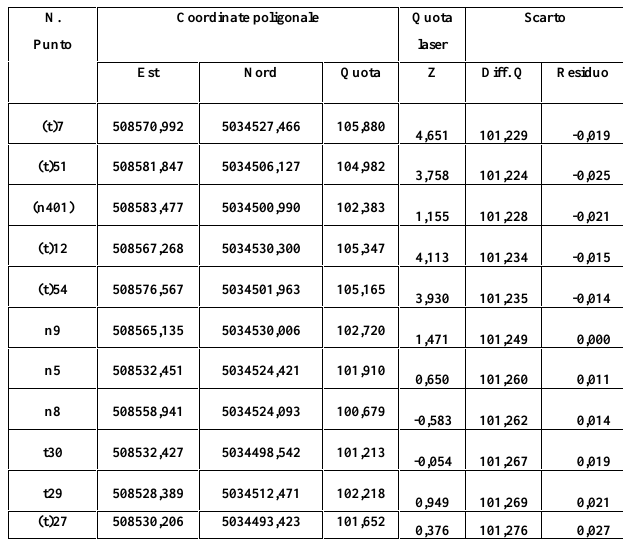
Table 1 – Rototraslation between the two coordinates systems: outputs The thickness of walls and floors, as well as uprightness of vertical structures etc. are then metrically reliable, as processed as a result of alignment of scans of contiguous spaces included in the general registration.